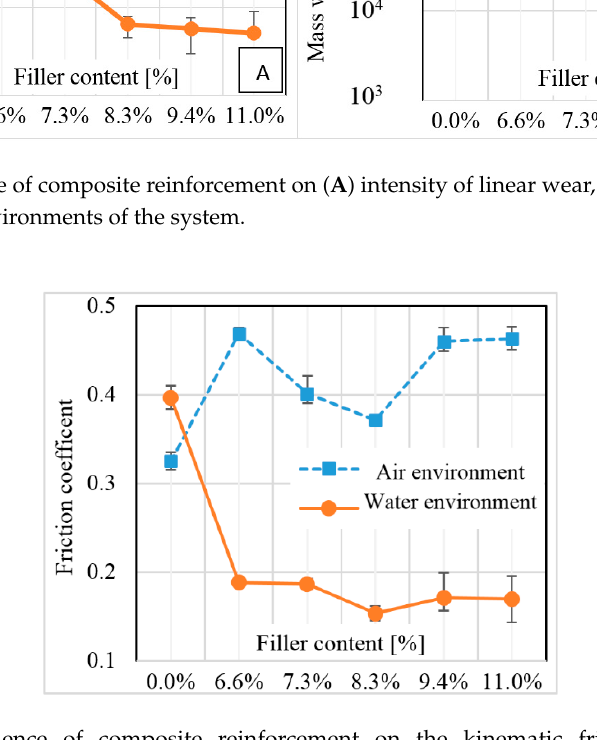
Figure 12. Influence of composite reinforcement on ( A ) intensity of linear wear, ( B ) intensity of mass wear in various environments of the system.